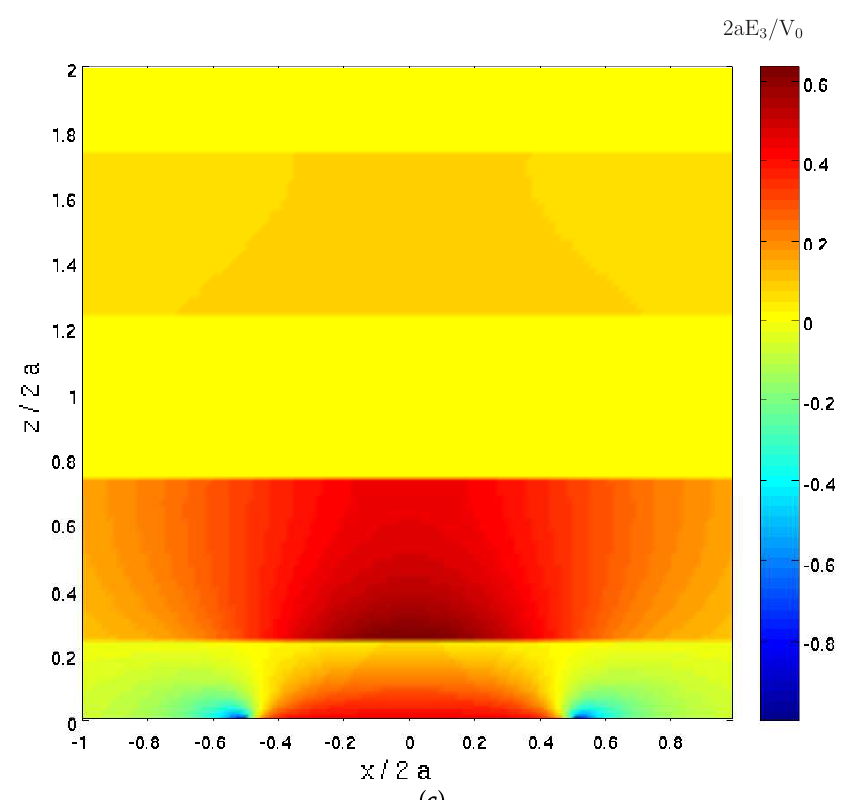
Figure 6. A piezoelectric half-plane which consists of periodic PZT-7A and cadmium selenide layers: An electrode of electric potential V 0 is attached to the PZT-7A layer at the surface z = 0. ( a ) The variations of the induced normal stress σ 33 , electric displacement D 3 , and electric field E 3 along the crack line at z / a =1. ( b ) The distribution of the induced normal stress σ 33 in the region − 1 ≤ x /2 a ≤ 1, z /2 a ≤ 2. ( c ) The distribution of the normal component of the electric field E 3 in the region − 1 ≤ x /2 a ≤ 1, z /2 a ≤